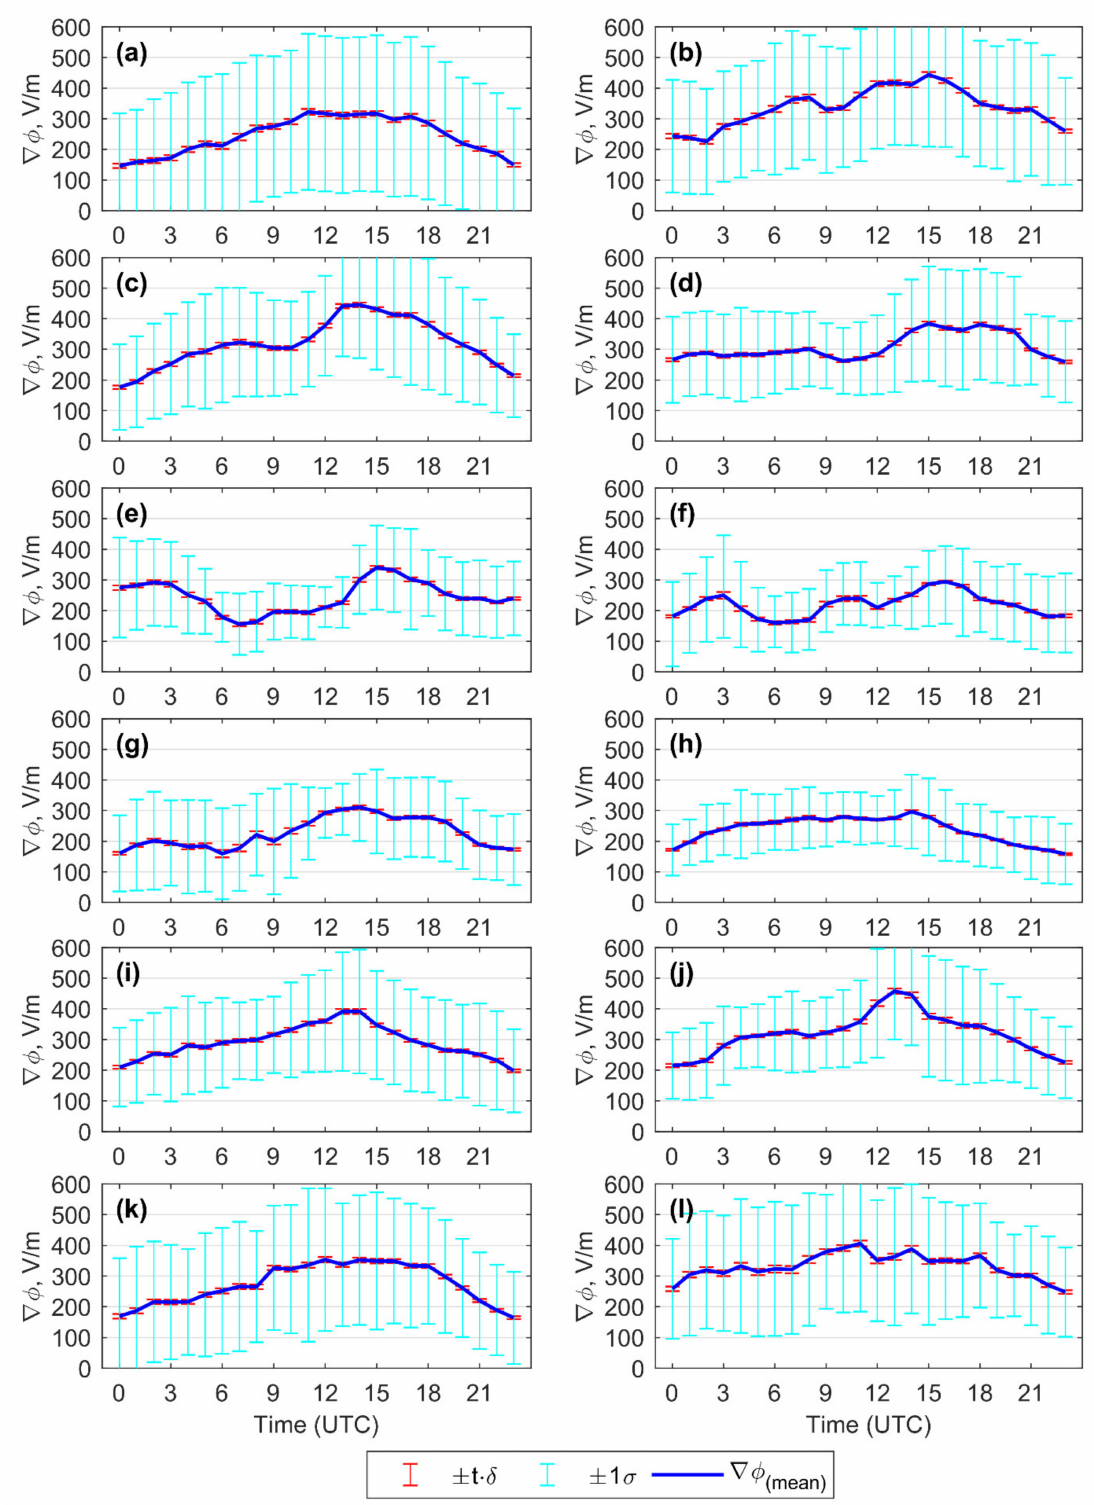
Figure 4. Hourly mean diurnal variation in the potential gradient under fair-weather conditions, calculated for the specific months: January ( a ), February ( b ), March ( c ), April ( d ), May ( e ), June ( f ), July ( g ), August ( h ), September ( i ), October ( j ), November ( k ), December ( l ). In this figure, the width of the confidence interval ± t · δ is determined by the multiplication of the Student’s t -value ( t ) √ and the standard error of the mean ( δ = σ / N, where σ —standard deviation, N—sample length), and ± 1 σ —the range equal to one standard